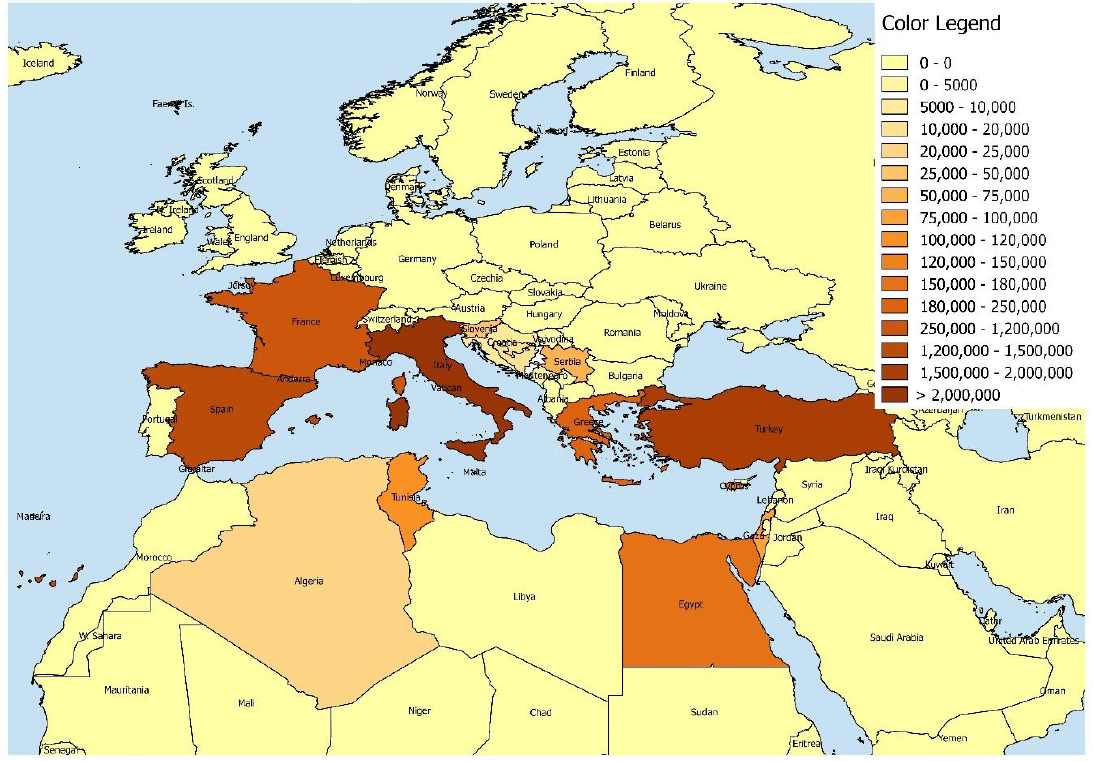
Figure 6. Plant material import scale (UN Comtrade code 06) from X. citri risk countries (2018).